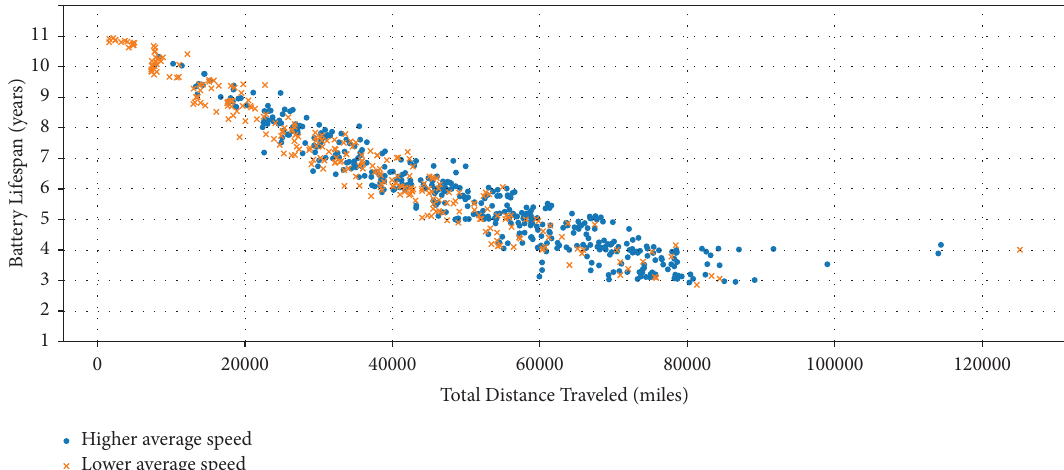
Figure 8: Battery lifespan vs. total distance traveled for average speed-based classifcation.